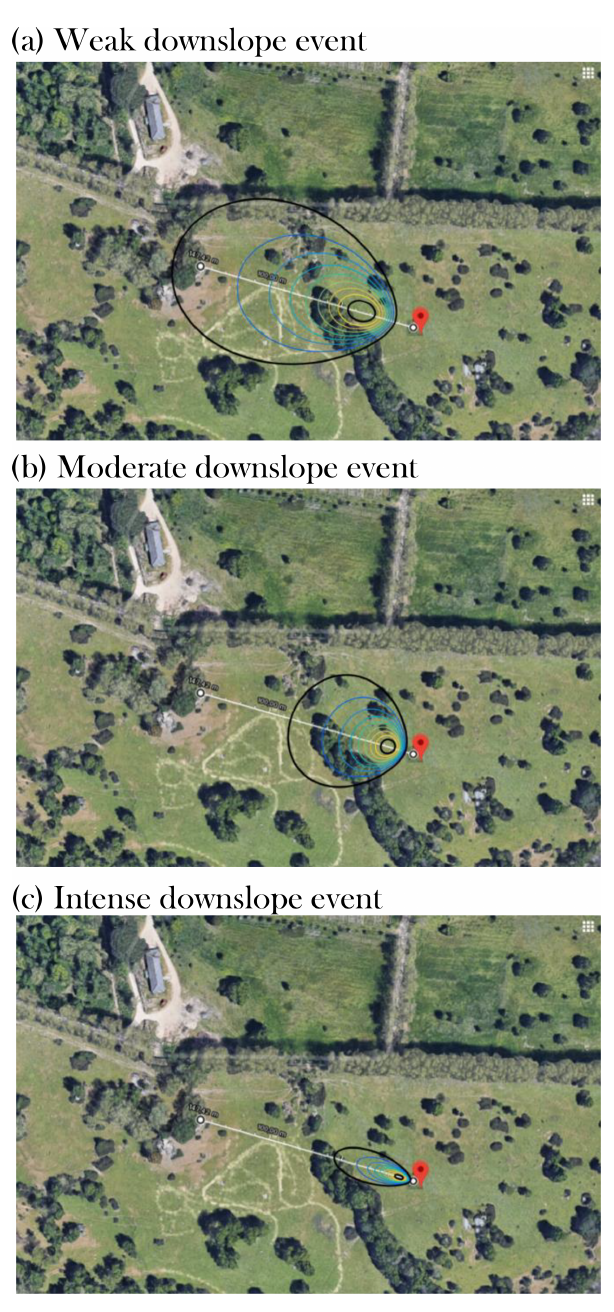
Figure A1. Estimation of the footprint area for the turbulent fluxes at 8m in the mean local downslope direction (295 ◦ ) in La Herrería for (a) a weak (13 August 2017), (b) a moderate (25 July 2017) and (c) an intense (27 July 2017) downslope event. Black contour lines delimit 90% and 10% of the total flux footprint. Map data ©2019 Google, Inst. Geogr. Nacional (Spain), last access: 19 Febru- ary